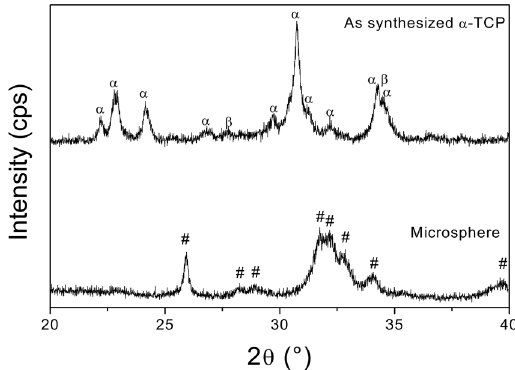
Figure 1: XRD patterns of the as synthesized α-TCP and one microsphere condition obtained by W/O emulsion. (α: α-TCP, β: β-TCP, #-